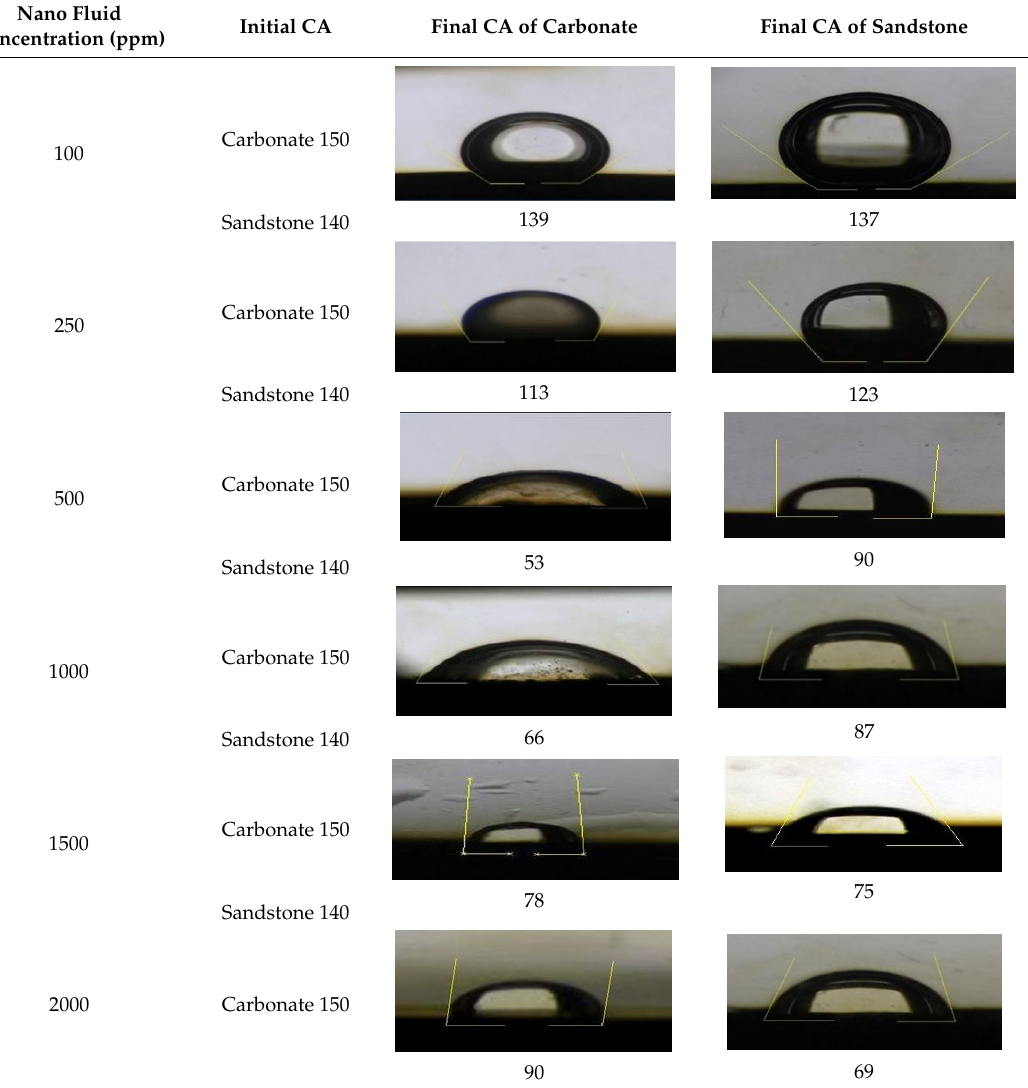
Table 4. The effect of the nanofluids prepared with different concentrations of the NC on wettability (contact angle or CA) of the tested carbonate and sandstone samples. The contact angles were measured by using the pendant drop method and an image of the oil droplet on the thing sections were captured.